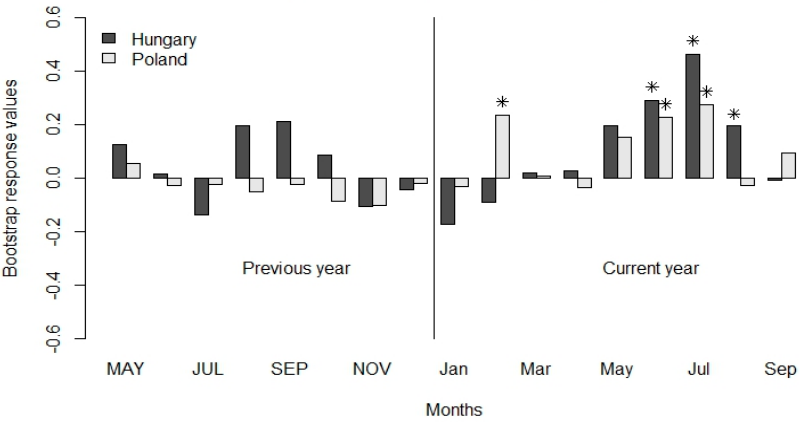
Figure 3. Relationship between tree growth and precipitation in Hungary and Poland. Asterisk (*) indicates significance at p < 0.05.